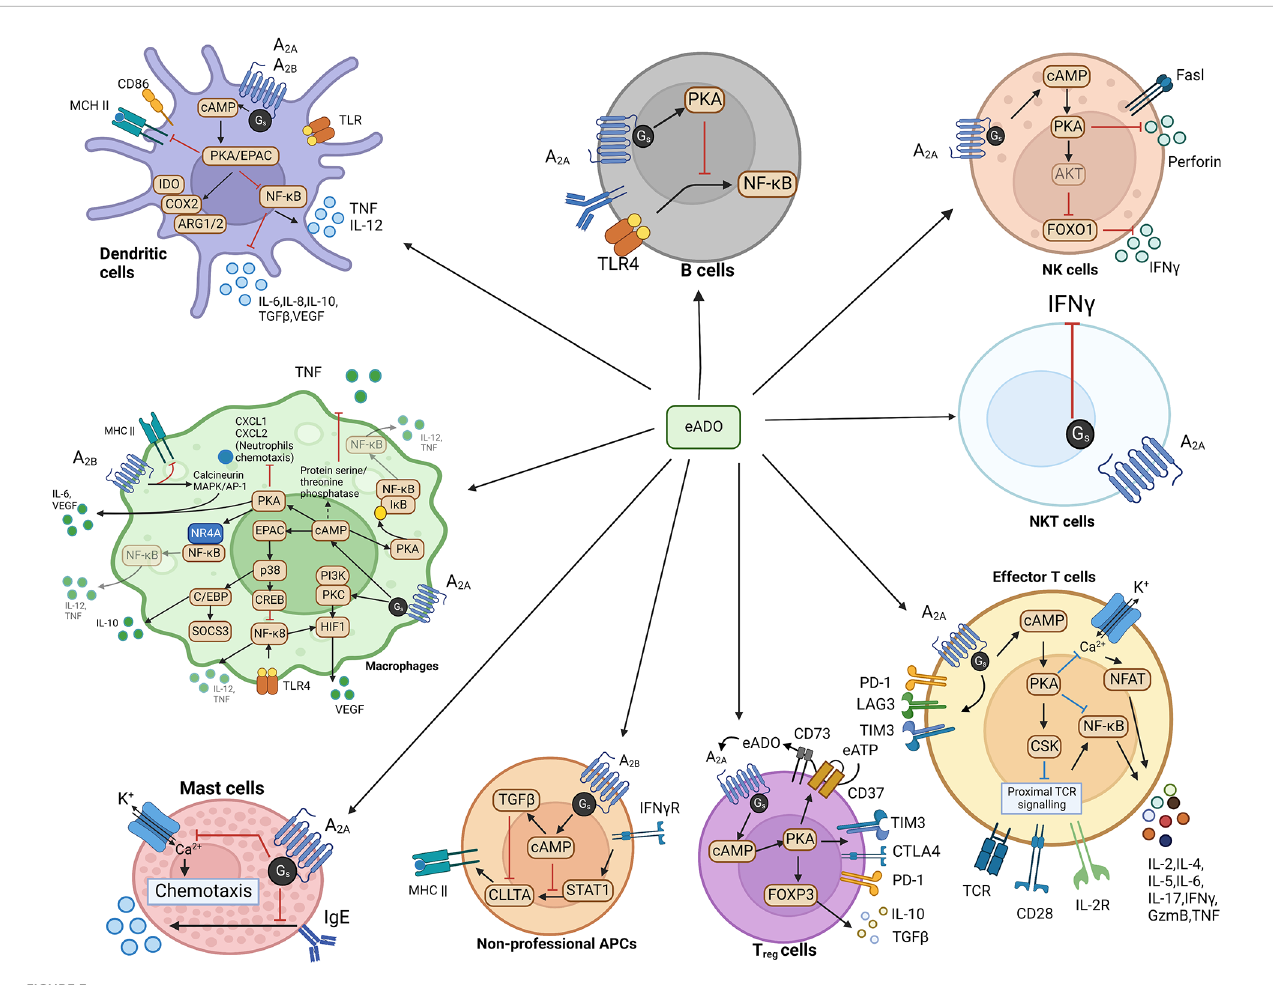
FIGURE 3 eADO/adenosine signaling in various immune